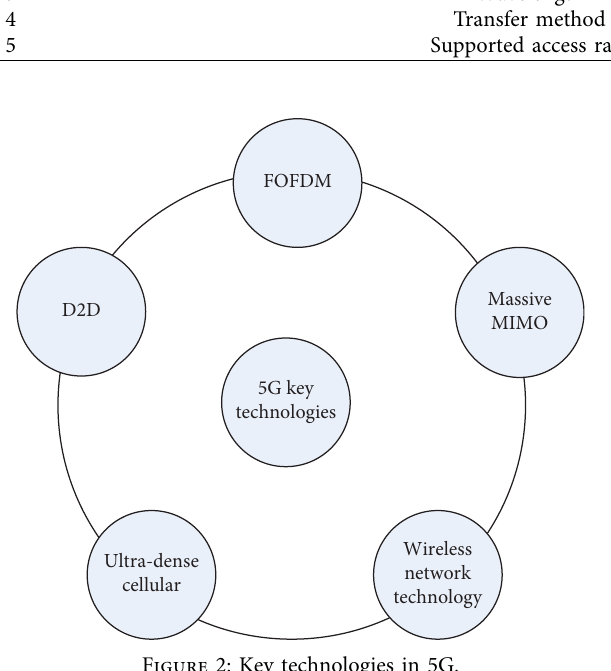
Figure 2: Key technologies in